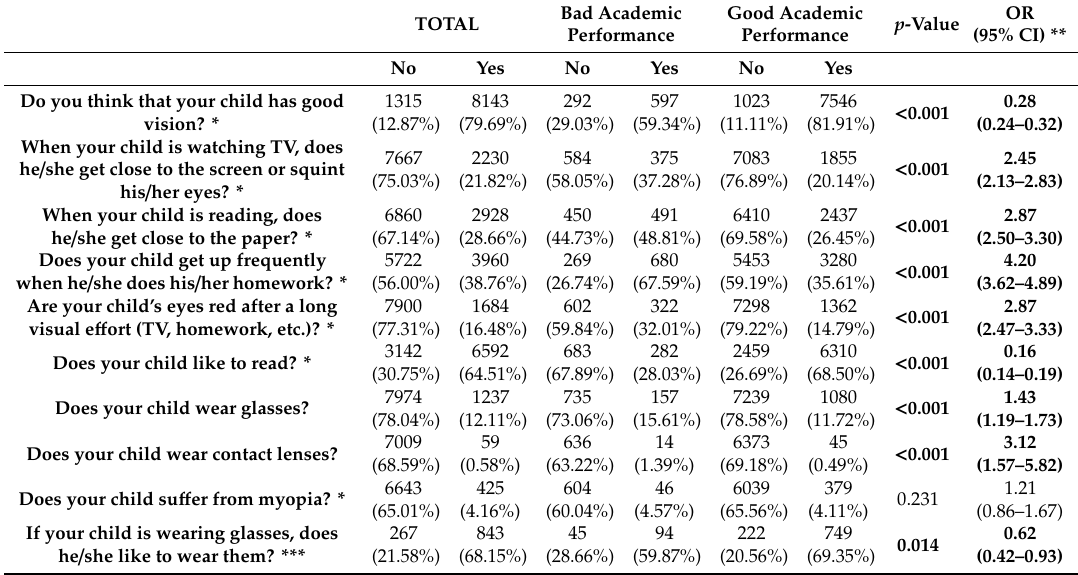
Table 3. Answers given by families about their children’s visual